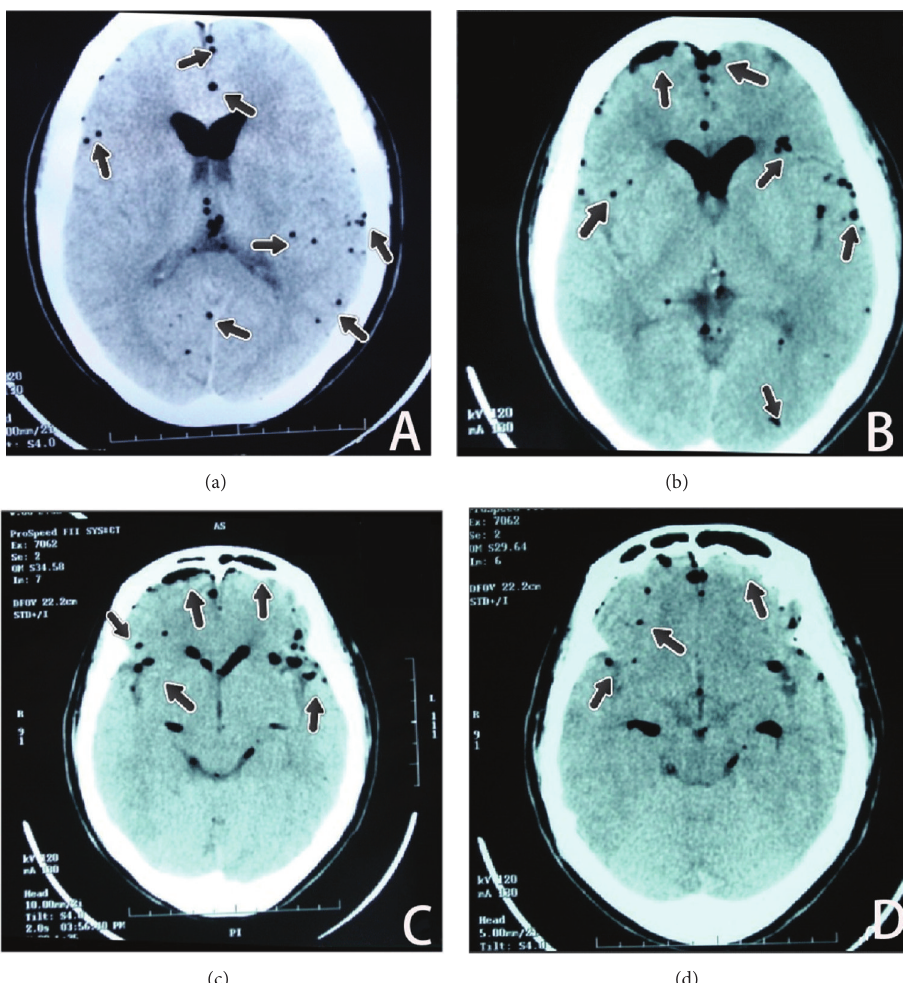
Figure 1: CT of the cerebral immediately after the patient evolved into light coma demonstrating multiple hypointensity spots in cerebral cortex (a), encephalocoele, right frontal lobes (b), right frontal lobes, left anterior temporal lobe (c), and anterior encephalocoele